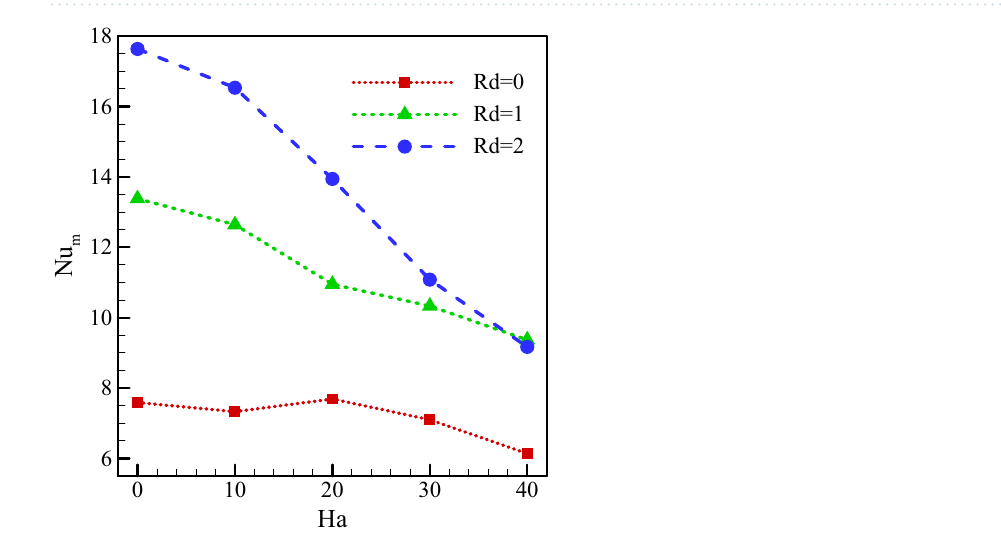
Figure 12. Average Nusselt number on the warm surface for Ra = 10 5 , ω = 0, ϕ = 0.03, γ = 45 ◦ and various Hartmann numbers and radiation